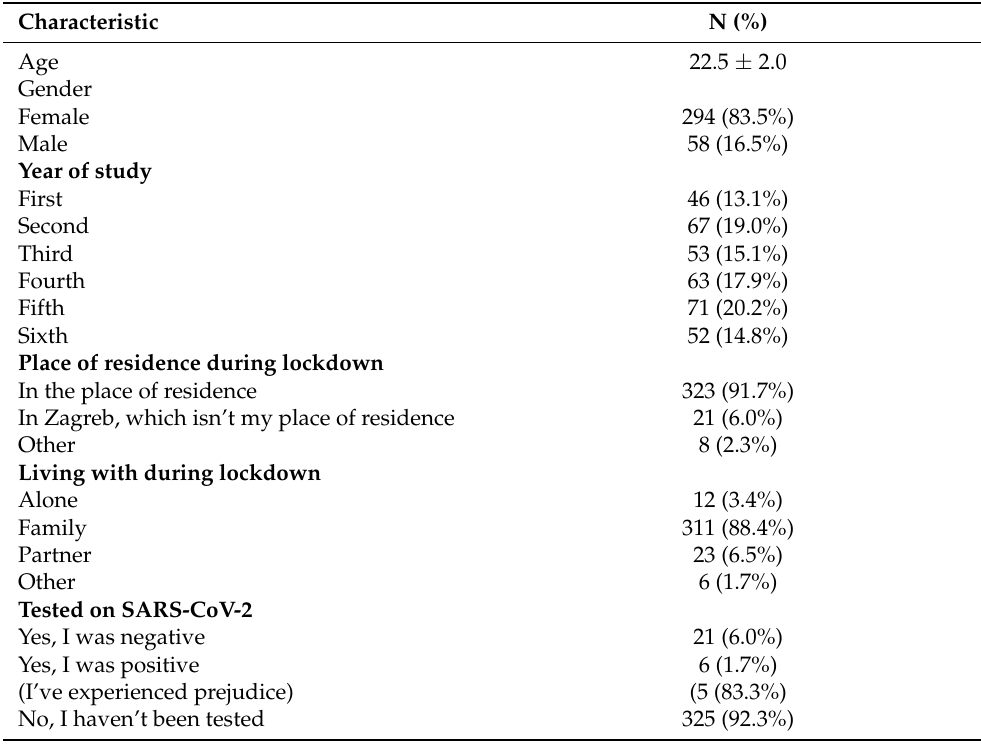
Table 1. Sociodemographic characteristics of participants (N =